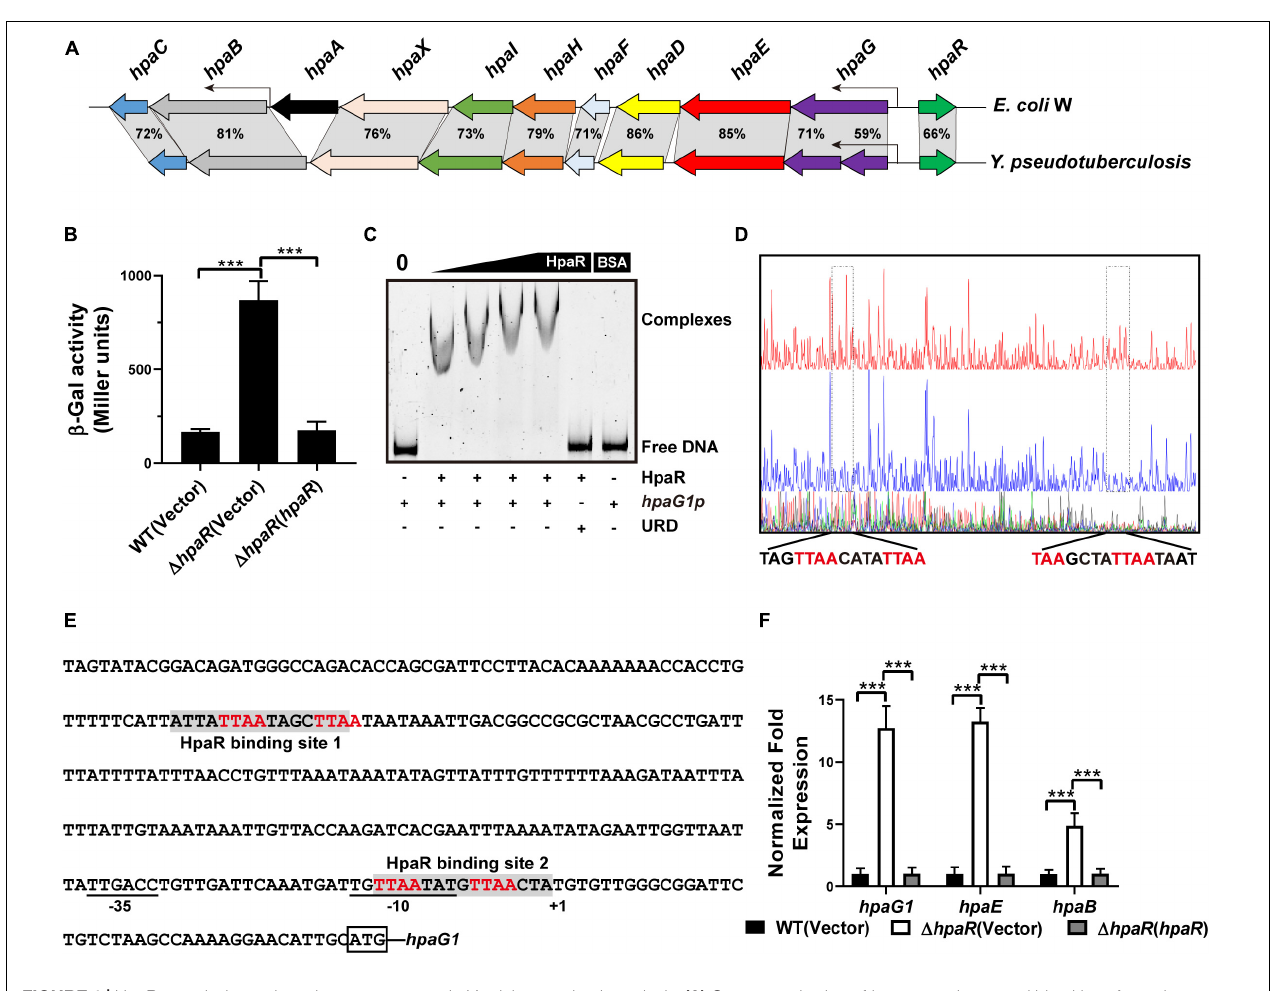
FIGURE 1 | HpaR negatively regulates hpa-meta operon in Yersinia pseudotuberculosis . (A) Gene organization of hpa-meta cluster and identities of protein sequence in Escherichia coli W and Y. pseudotuberculosis . (B) β -Galactosidase activity of the hpaG1 promoter in Y. pseudotuberculosis Wild-type, (cid:49) hpaR mutant, and its complementary strain (cid:49) hpaR ( hpaR ). Data shown are the average of three independent experiments. The error bars indicate standard deviations of the average. *** P < 0.001. (C) EMSA was performed to analyze the interactions between His 6 -HpaR and the hpaG1 promoter. URD, unrelated DNA fragment. (D) Identification of the HpaR-binding site within the hpaG1 promoter using the DNase I footprinting assay. Letters in red denote inverted repeat sequences. (E) The HpaR binding sites detected by DNase I footprinting assay were shown in the hpaG1 promoter region by shading. Letters in red denote inverted repeat sequences. (F) Relative expression levels of hpaG1 , hpaE, and hpaB were measured by quantitative RT-PCR in wild-type, (cid:49) hpaR mutant, and complementary strain (cid:49) hpaR ( hpaR